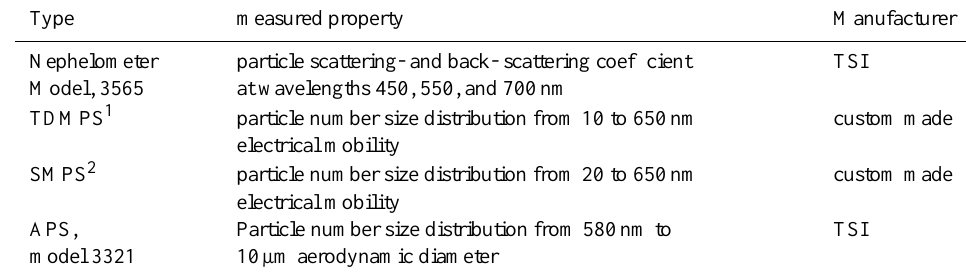
Table 3. Instrumentation used for aerosol characterization during the GAW2005 and EUSAAR2007 workshops.